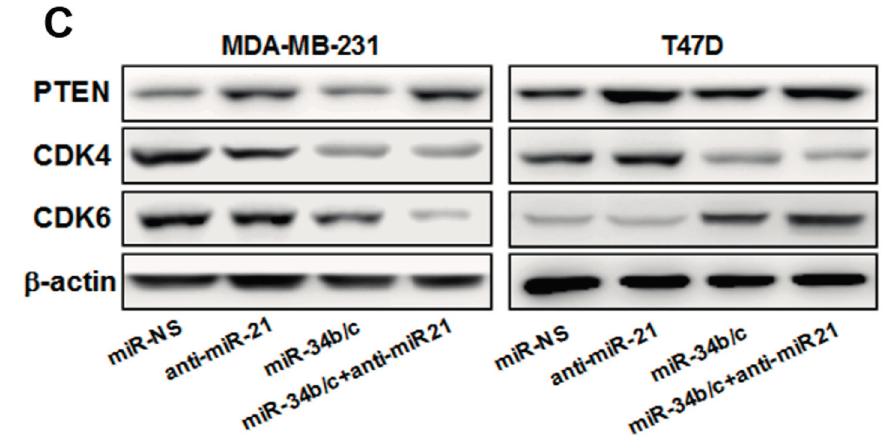
Figure 2. Functional roles of miR-21 and miR-34b/c in breast cancer. ( A ) MDA-MB-231 cells stable-expressing non-sense sequence (NS), anti-miR-21 and/or miR-34b/c were subcutaneously injected into immunodeficient mice. Tumor volumes were measured every five days. Xenografts were removed 30 days after implantation. Tumor volumes were obtained and presented (mean ± SEM; n = 8). * p < 0.05, ** p < 0.01; ( B ) Immunohistochemical (IHC) staining of PTEN, CDK4, and CDK6 in representative breast carcinoma tumors and non-malignant normal adjacent tissues. (×200 magnification); and ( C ) T47D and MDA-MB-231 cells were infected with lentivirus carrying non-sense sequence (NS), anti-miR-21 and/or miR-34b/c. The expression levels of PTEN, CDK4, and CDK6 in these cells were analyzed by Western